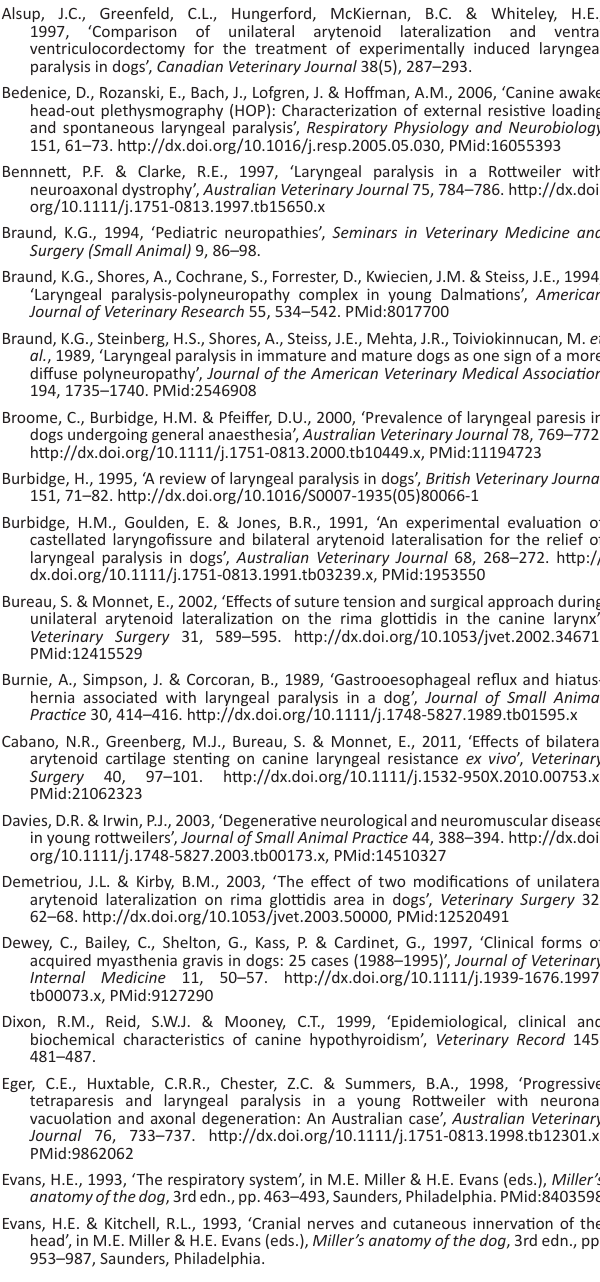
FIGURE 6: Schematic presentation of the castellated laryngofissure technique, depicting, (a) the ventral view of the thyroid cartilage indicating the stepped incision and (b) the advancement of the cartilage